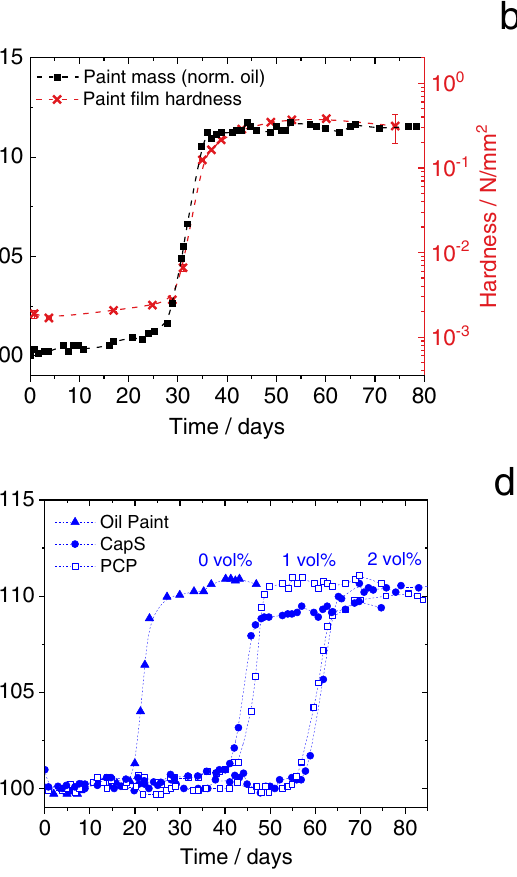
between the start and the maximum of the weight increase. c , d Mass increase, normalizedtotheoilcontent,ofUB(blue)orLW(black)paintsamplespreparedas oil paints (triangle), capillary suspension CapS (circle) or PCP (square) paints as a function of time. c UB CapS and PCP paints contain 1 and 2vol% of EY solids. d LW CapS and PCP paints contain 4vol% of EY solids. All studied paints contained a solids fraction (pigment and EY solids) of φ